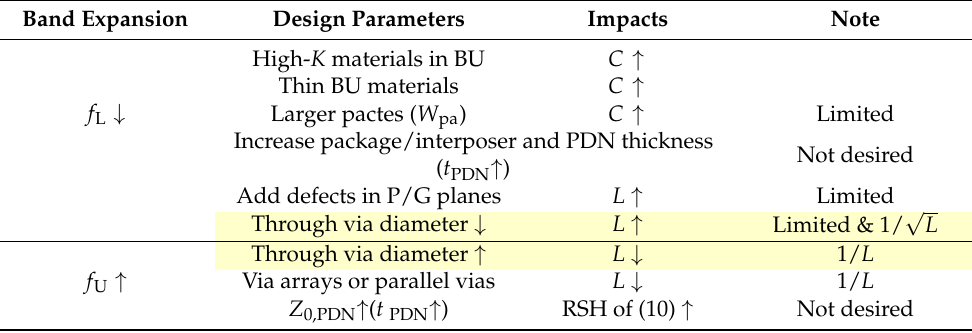
Table 4. Stopband expansion method by changing design parameters and